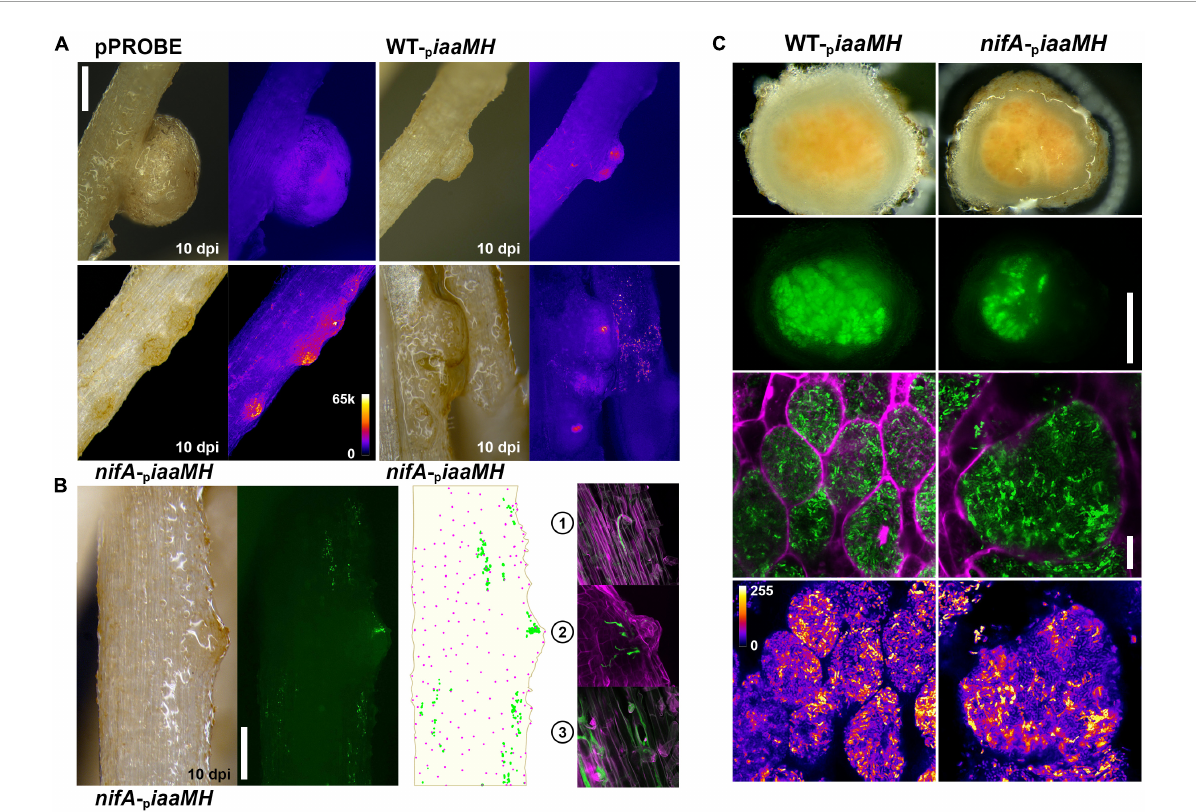
FIGURE4 In situ monitoring of iaaMH promotor activity. (A) p iaaMH -driven gfp expression in Phaseolus vulgaris roots in the given conditions. Upper-left, note the absence of specific fluorescence in mature nodules occupied by pPROBE-only inoculants. Upper-right, wild-type Paraburkholderia phymatum occasionally triggers fusing nodules. Note the fluorescent signals scattered on the root epidermis. Lower left, note the higher GFP fluorescence in single and fused developing nodules or on the epidermis infected by the nifA mutant. Lower right, two nifA -occupied roots displaying either developing nodules or heavily colonized epidermal area. All micrographs were acquired with the same acquisition settings, Fire LUT, 16-bit depth. Bar = 500 µ m. (B) GFP signals distribution on a nifA -colonized root. The cartoon depicts the overlapping of GFP signals (green) and identified root hair positions (magenta) from the micrograph. Bar = 500 µ m. (1) An arrested IT. (2) A branching IT and nodular outgrowth. (3) ITs and densely colonized epidermal cells. (C) Upper panel, transversal sections of p iaaMH : gfp expressing 21 dpi mature